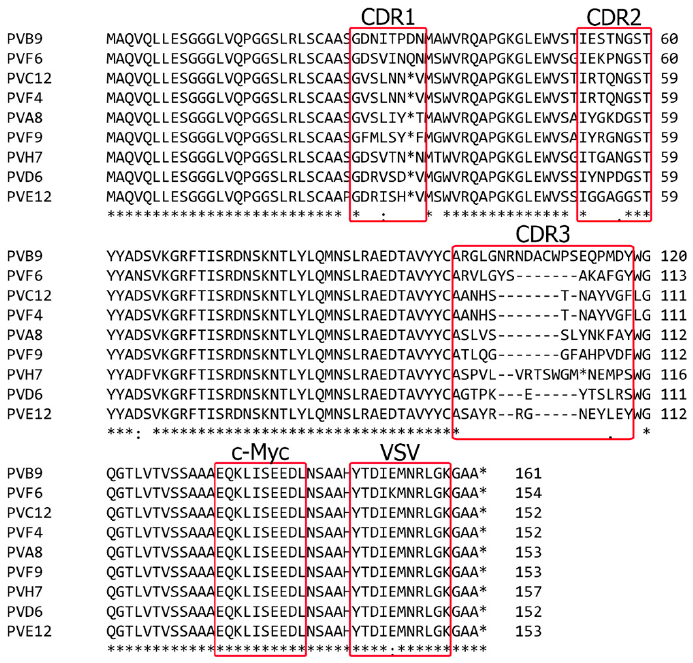
Figure 4. Amino acid sequences of the pistachio binding dAbs deduced from the nucleotide sequences by SnapGene tool. Positions of the complementarity determining regions of the variable domains (CDR 1–3) and the c-Myc and VSV tags are indicated as determined by IMGT/V-QUEST tool. Deduced amino acid sequences of the pistachio-binding clones showing the CDRs and immunoglobulin framework regions (FRs) demonstrated no insertions or deletions in CDR1 and CDR2 in any of the clones. As expected, CDR3 was the most variable in sequence and length among the selected clones, with lengths from 12 to 20 residues. Moreover, a stop codon was present in the CDR1 of six clones, and in CDR3 or one clone, due to an amber mutation (Figure 4). This is frequent in phage displayed antibodies because of randomization of CDR sequences and propagation of phagemids in the amber suppressor TG1 E. coli strain [27]. Amber stop codons are interpreted as Gln residues in suppressor strains like TG1, so that these dAb clones can be used in a phage display